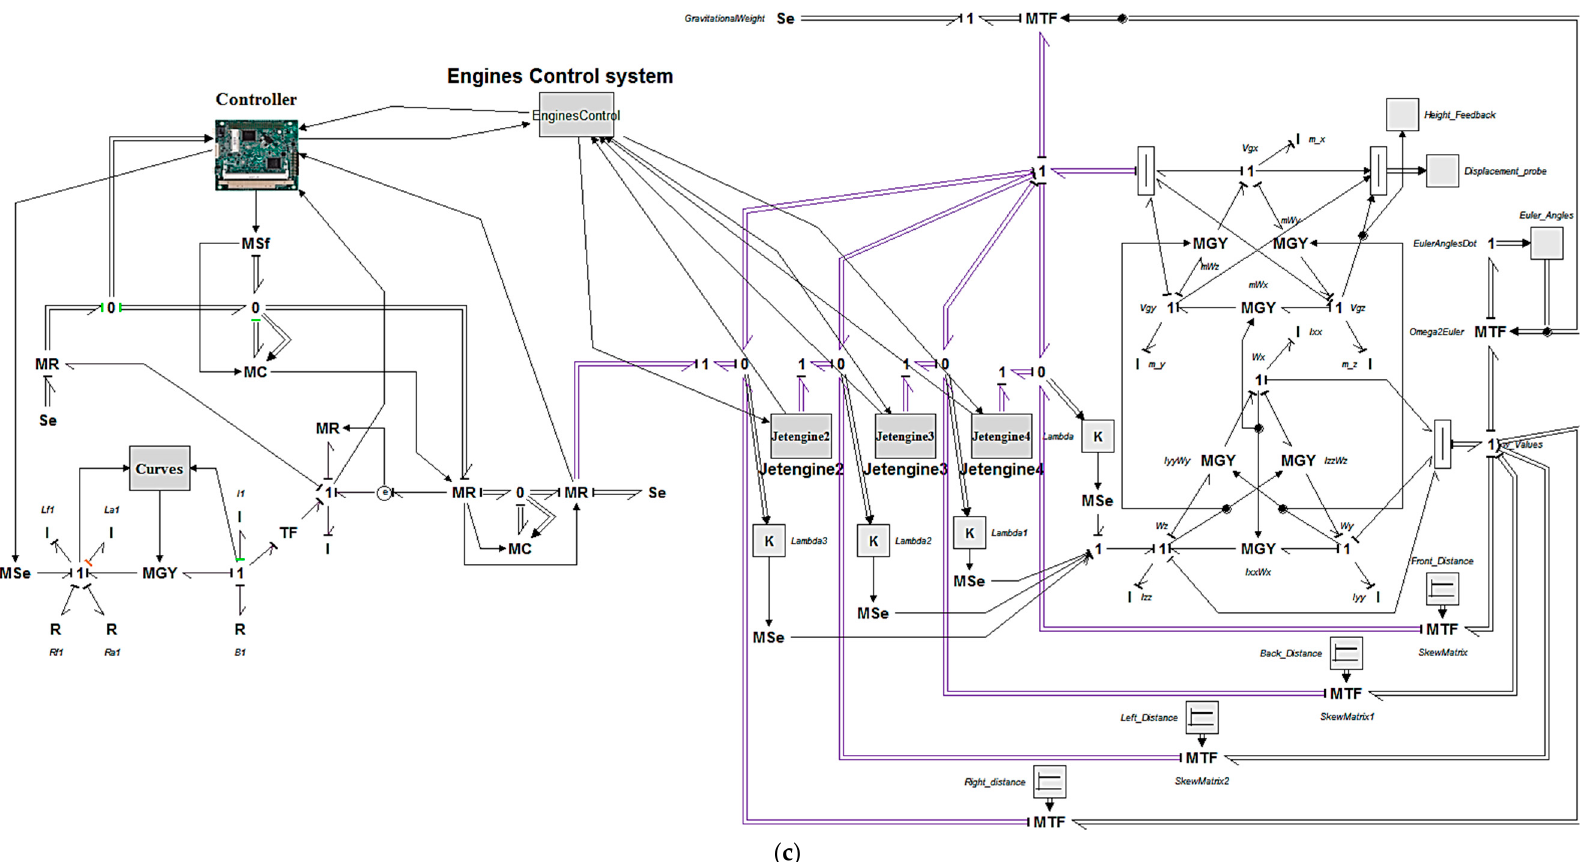
Figure 6. AB4 JetQuad bond graph model: ( a ) Bond graph model of jet engine; ( b ) bond graph representation of Euler equations; ( c ) combined bond graph model of the JQ.